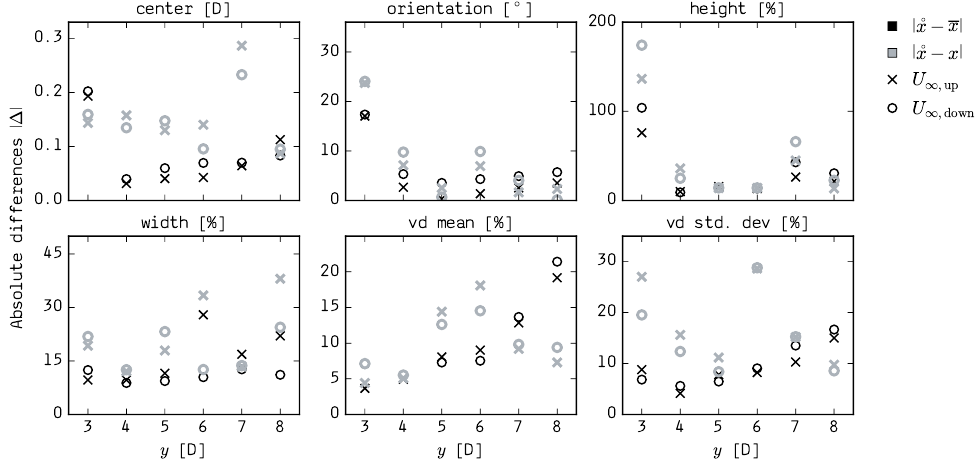
Figure 8. Absolute differences | ∆ | in wake metrics for the LES synthetic scans (derived using the disjunct sampling equivalent to field measurements) relative to the metrics derived using the 12-min mean LES dataset (black) and the instantaneous fields from LES at the first second of the scan (gray). The different symbols refer to the free stream profile U ∞ ( z ) used to derive vd and characterize the virtual scan wakes as described in the text. Variables and units of absolute difference are given for each subplot. For all subplots, the horizontal axis is the distance downstream of the